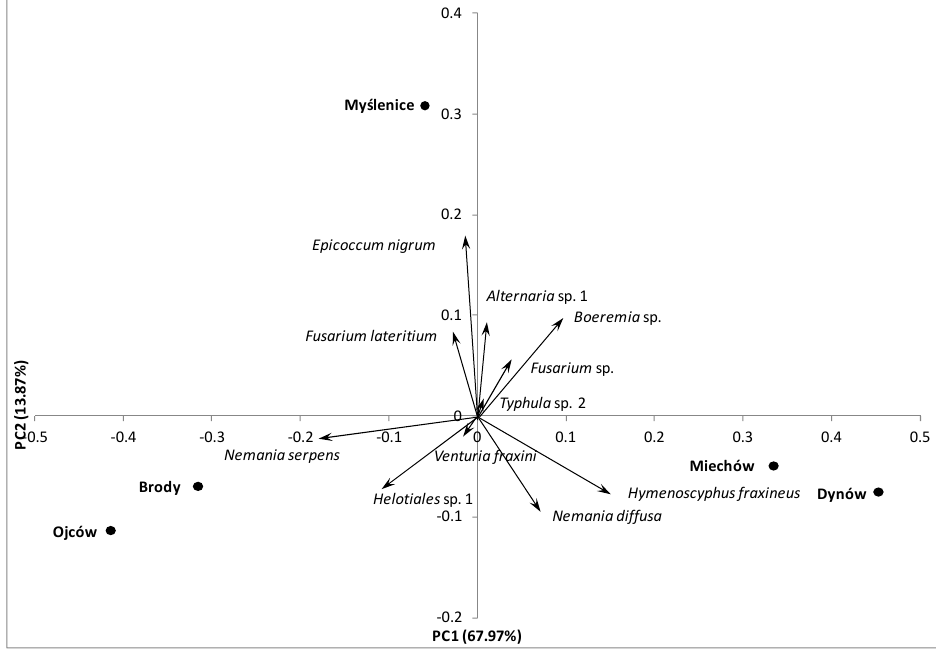
Figure 2. Principal component analysis (PCA) with frequencies of fungal variables represented by arrows and sites represented by black circles, for mycobiota isolated from the previous year’s leaf petioles of F. excelsior .